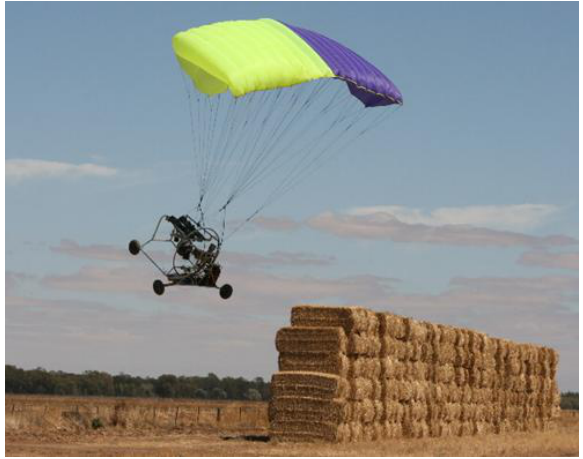
Figure 6. SUSI 62 soon after takeoff